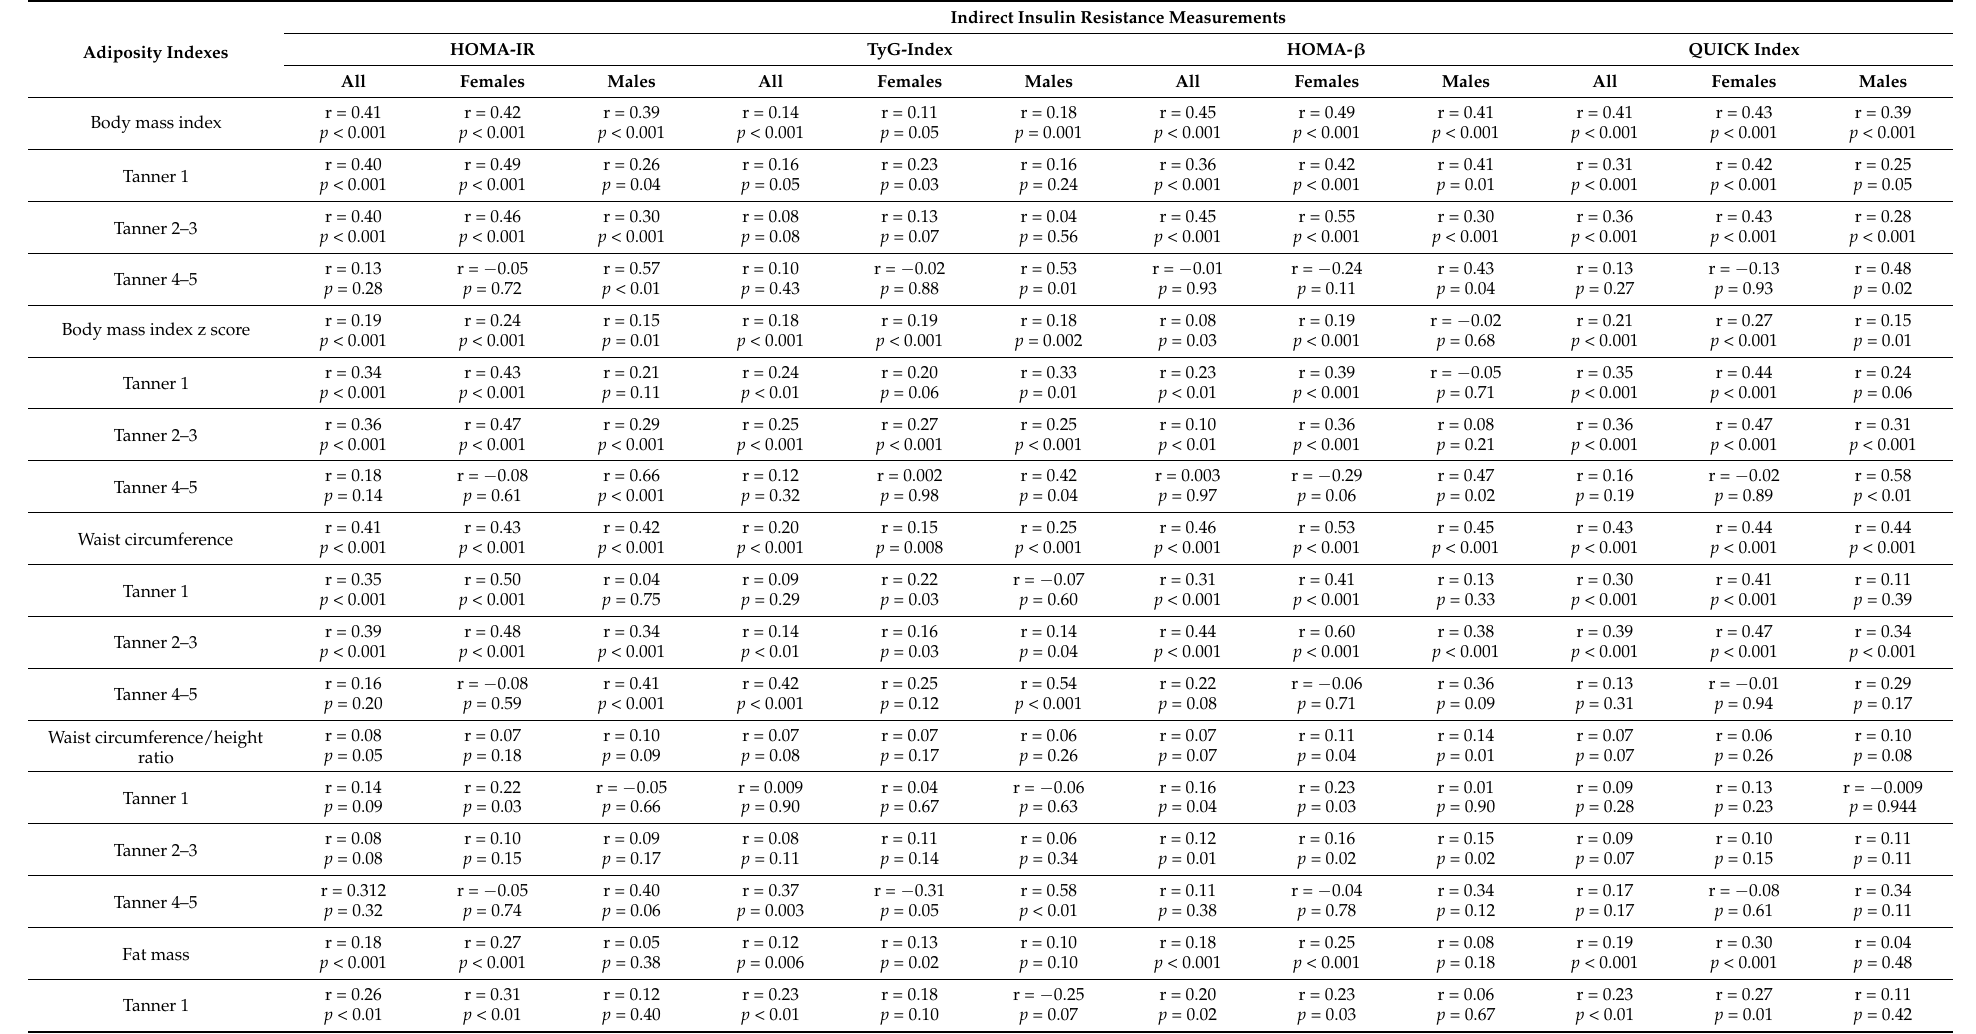
Table 2. Correlation between insulin resistance measurements and adiposity